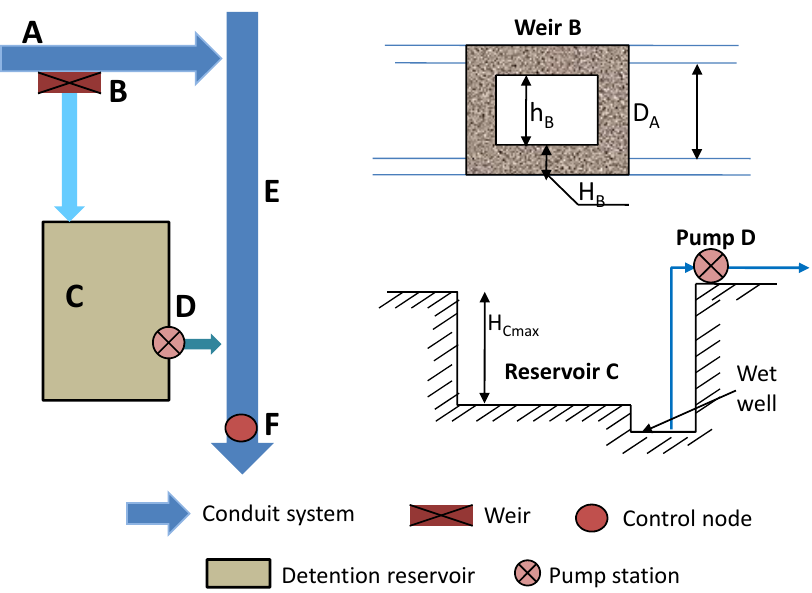
Figure 1. Schematic representation of detention reservoir